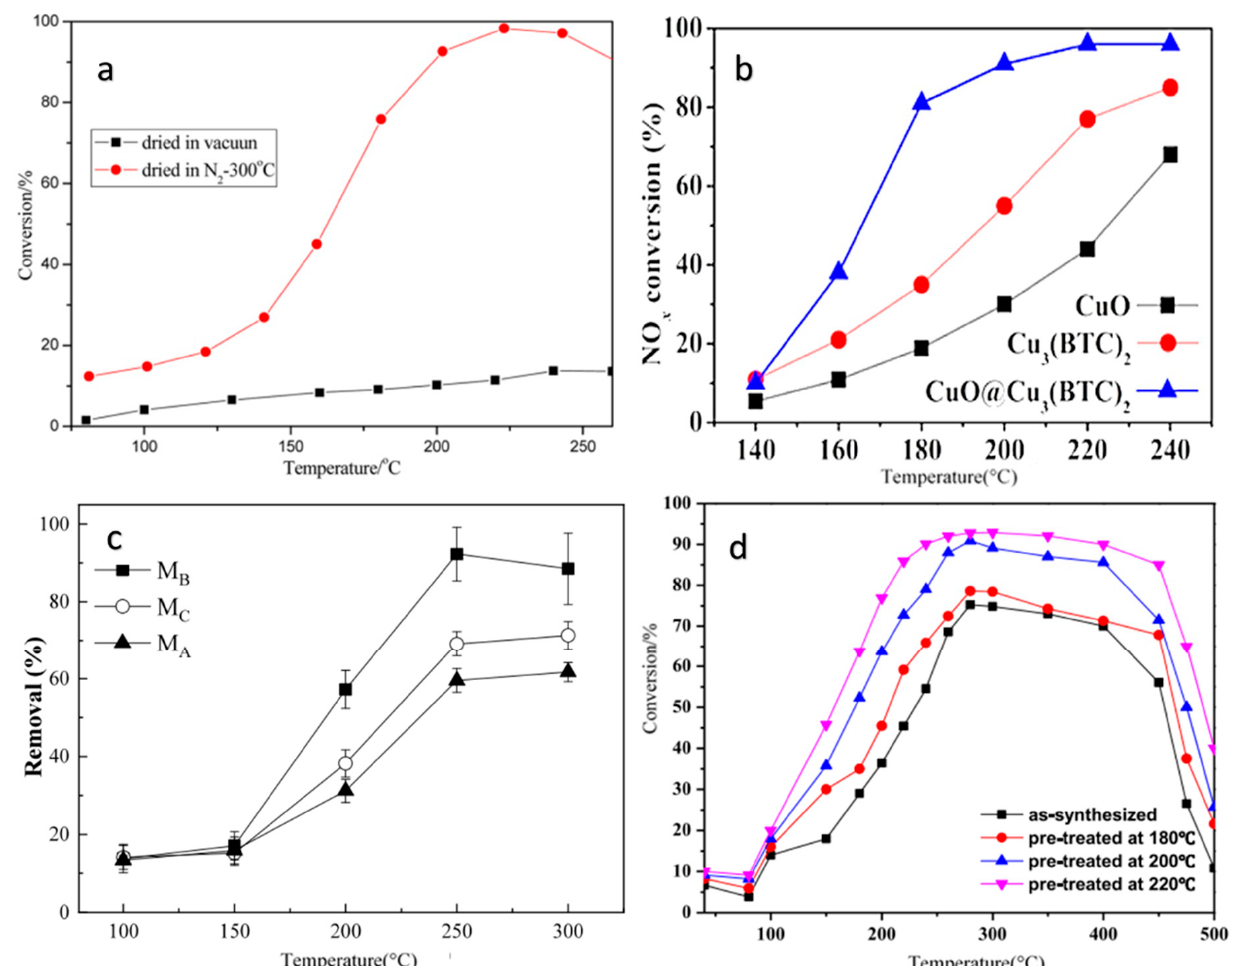
Figure 2. Monometallic MOFs catalysts for NO x SCR, ( a ) Mn-MOF [12] (copyright 2016 American Chemical Society), ( b ) Cu-MOF [18] (copyright 2017 American Chemical Society), ( c ) Fe-MOF [19] (copyright 2021 Elsevier) and ( d ) Ni-MOF [20] (copyright 2018 Elsevier).